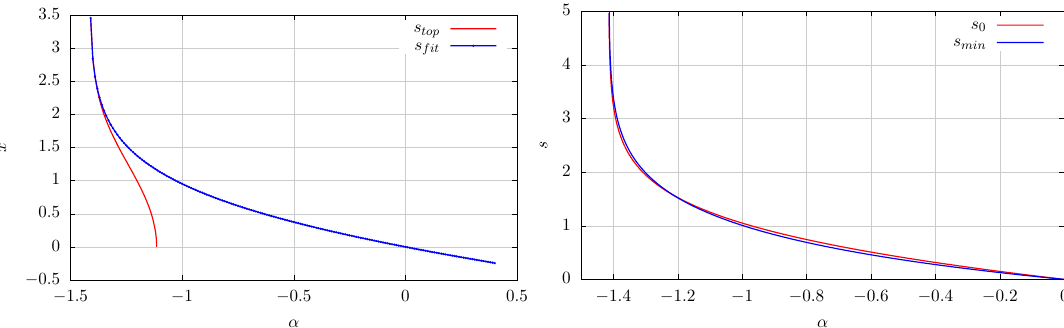
Figure 8 . Left: the distance between the hidden kink and antikink in the lump (blue line), together with the positions of the topological zeros (red line). Right: the distance s between the antikinks and the central kink in the Q = 0 BPS solution in the (cid:12)xed kink approximation, as a function of the impurity parameter (cid:11) . Blue line | the energy minimization. Red line | the integration of the BPS